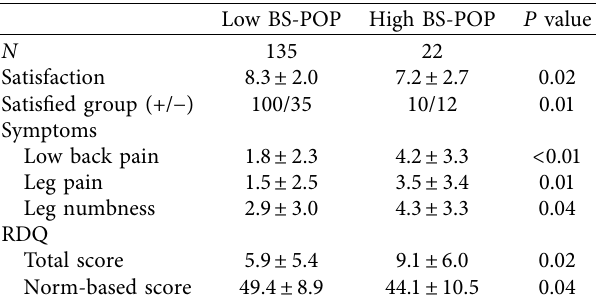
Table 2: Satisfaction, NRS symptom scores, and RDQ scores at the 1-year